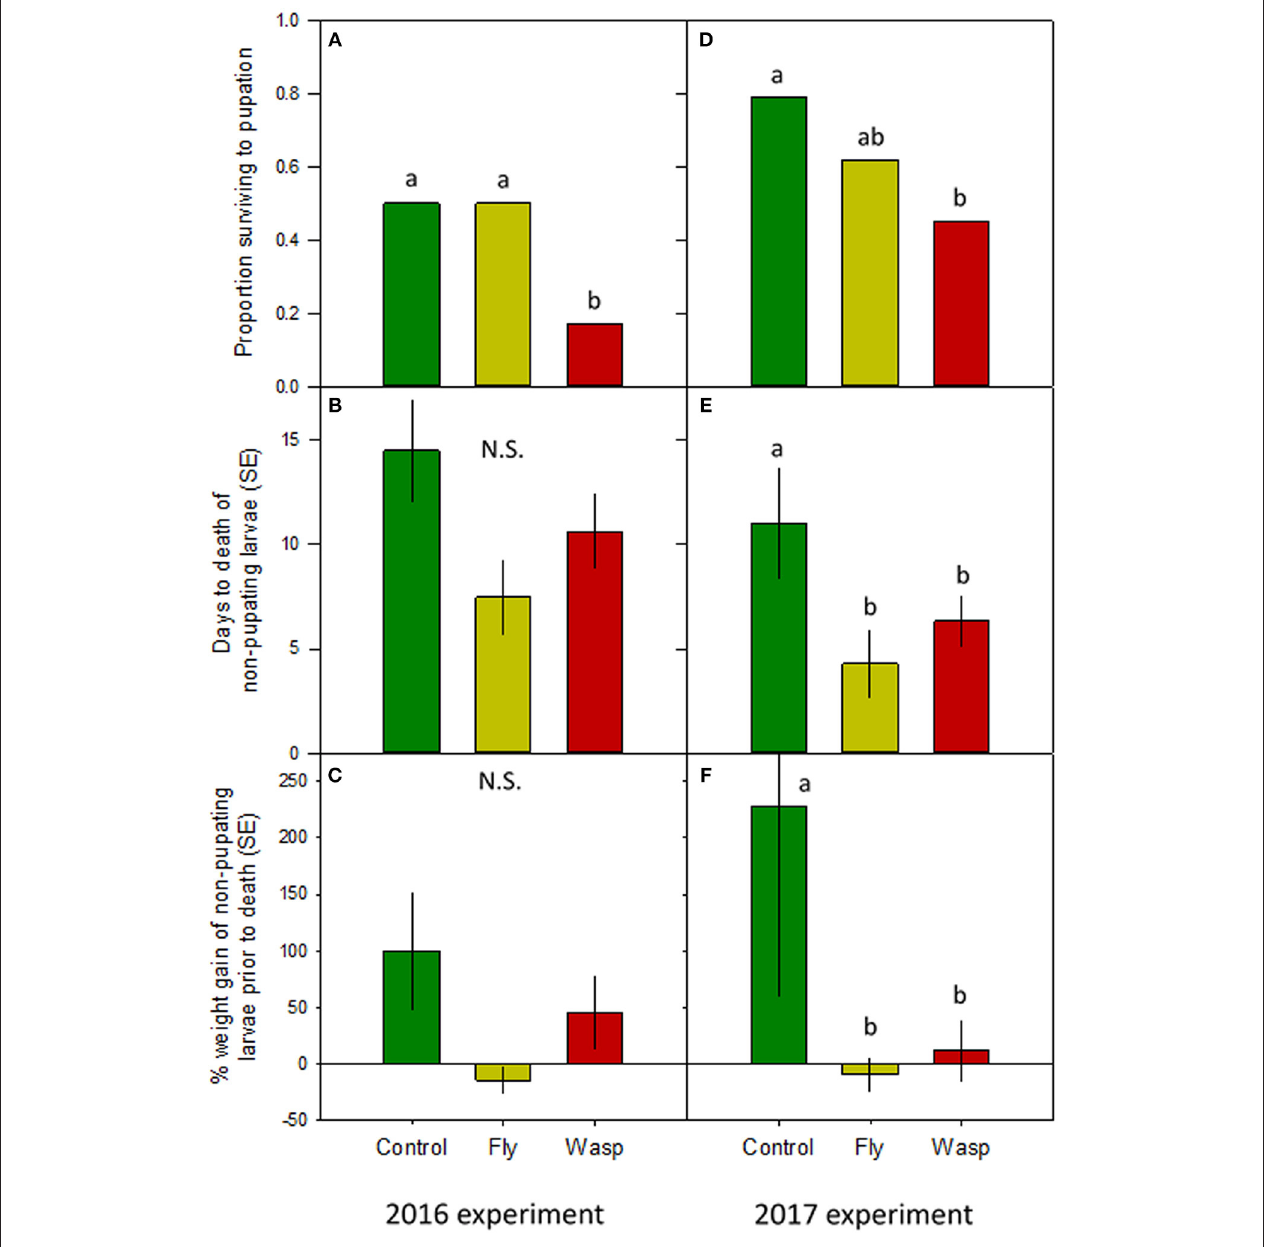
FIGURE 1 | Impact of varying risk cues on Actia luna larval development. Left-hand panels: 2016 experiment ( n = 18/treatment); right-hand panels: 2017 experiment ( n = 28–29/treatment). (A,D) : Proportion of A. luna larvae surviving to pupation. (B,E) : Mean ± SE days from the start of the experiment to death of non-pupating larvae. (C,F) : Percentage ± SE weight gain from hatching to death of non-pupating larvae. Green bars: no risk cues; yellow bars: risk cues from harmless scavenging fly; red bars: risk cues from Vespula sp. predatory wasp. Lower-case letters indicate treatments similar at α = 0.05 ( post-hoc Tukey HSD); N.S. = no significant differences among